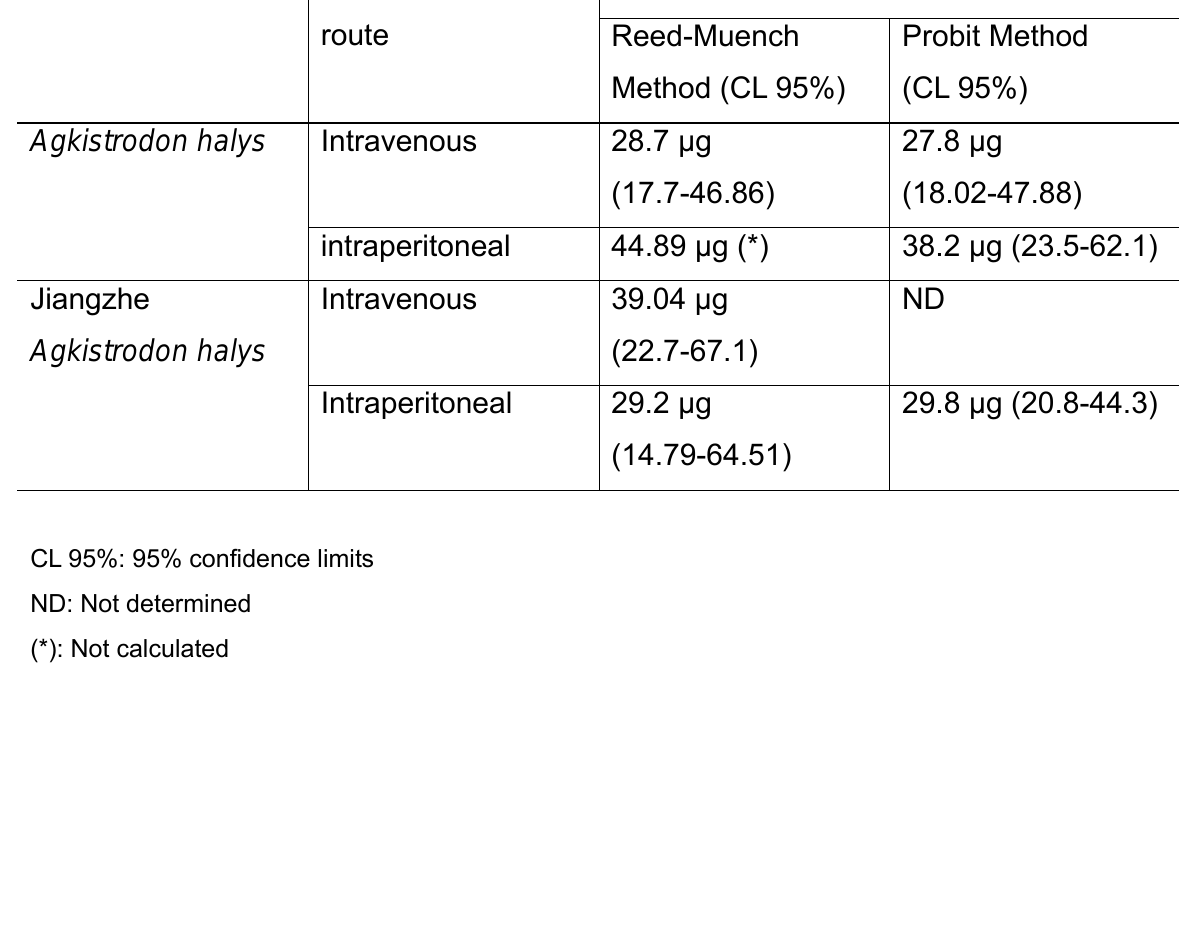
) of venoms intravenously or 50